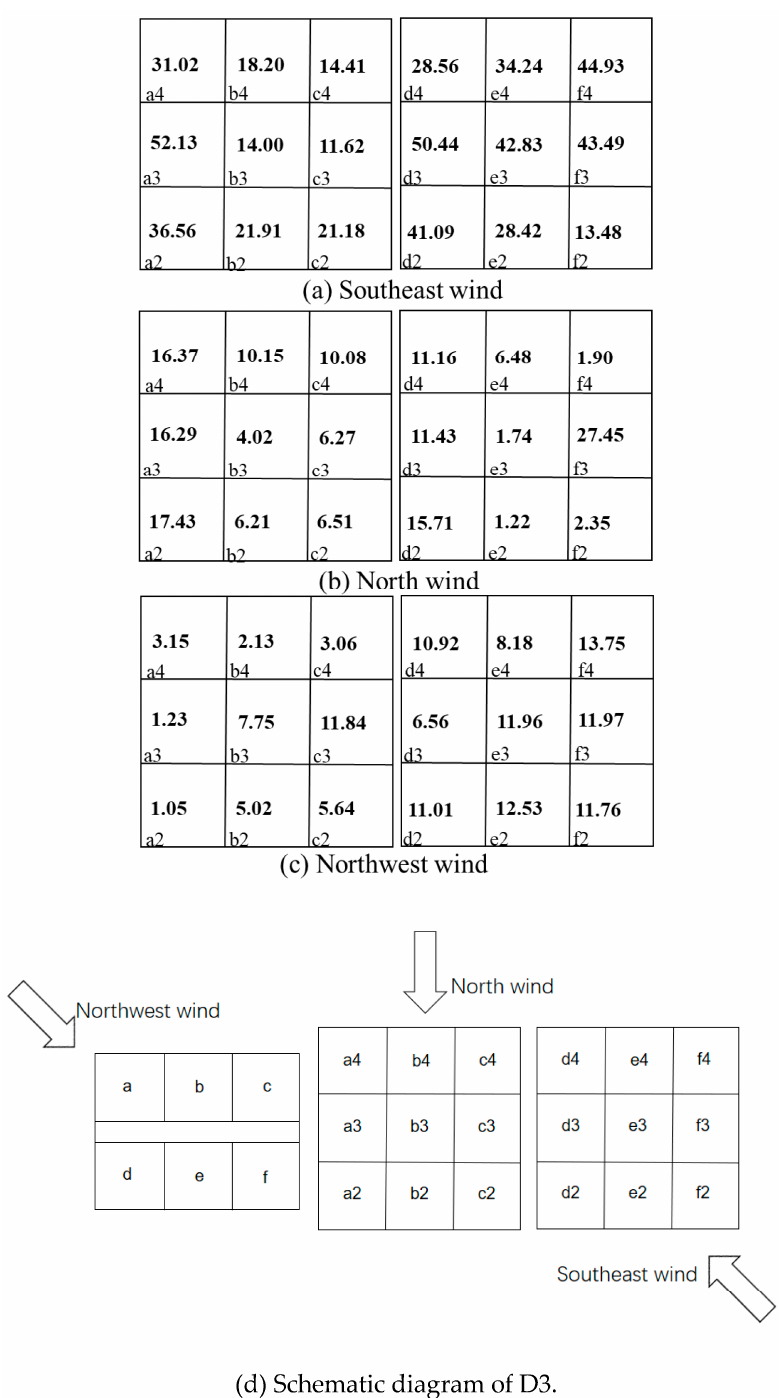
Figure 12. Ventilation rates of rooms ACH (h − 1 ) in D3. a1,2,3,4-e1,2,3,4 represent the number of dormitory room.